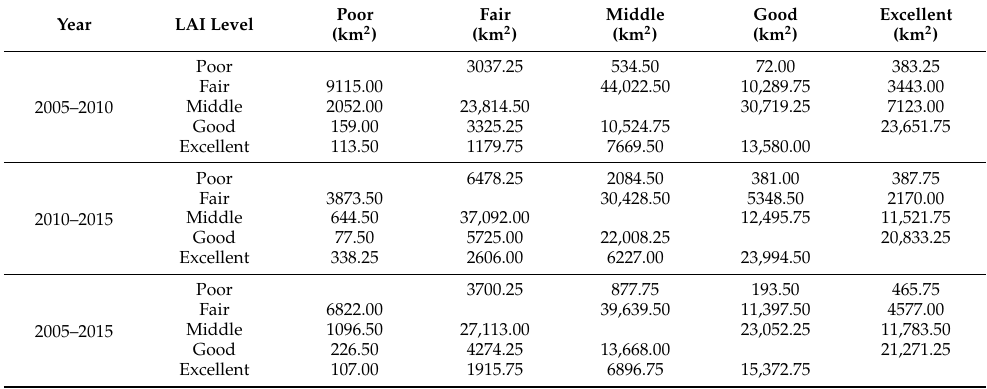
Figure 7. Sankey diagram of the area transfer matrix of different LAI levels in the NFB from 2005–2015. Table 7. Area transfer matrix of different LAI levels in the NFB from